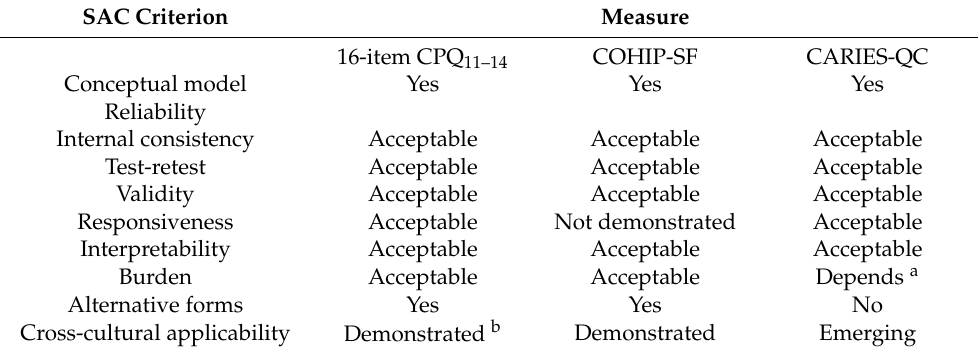
Table 8. Systematic evaluation of the three scales against the SAC